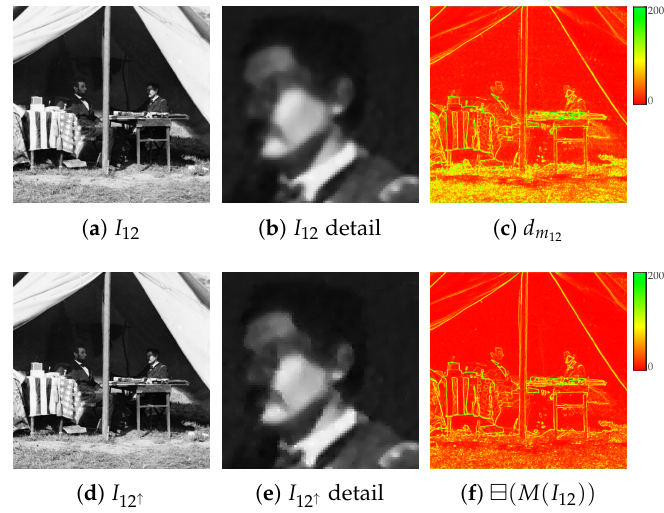
Figure 4. Data fusion step (see Section 2.3): ( a ) stacked median I 12 obtained from I 1 ∪ I (cid:63) , ( b ) details 2 → 1 of I 12 , ( c ) the stacked median d m of the gradient magnitudes of I 1 and I (cid:63) , ( d ) the gradient- 2 → 1 12 enhanced image I 12 ↑ , ( e ) a detail of I 12 ↑ , ( f ) the gradient magnitude (cid:12) ( M ( I 12 )) of the stacked median image I 12 . Best viewed in color. The reader is invited to zoom in on the electronic version of the manuscript in order to better appreciate the visual differences.